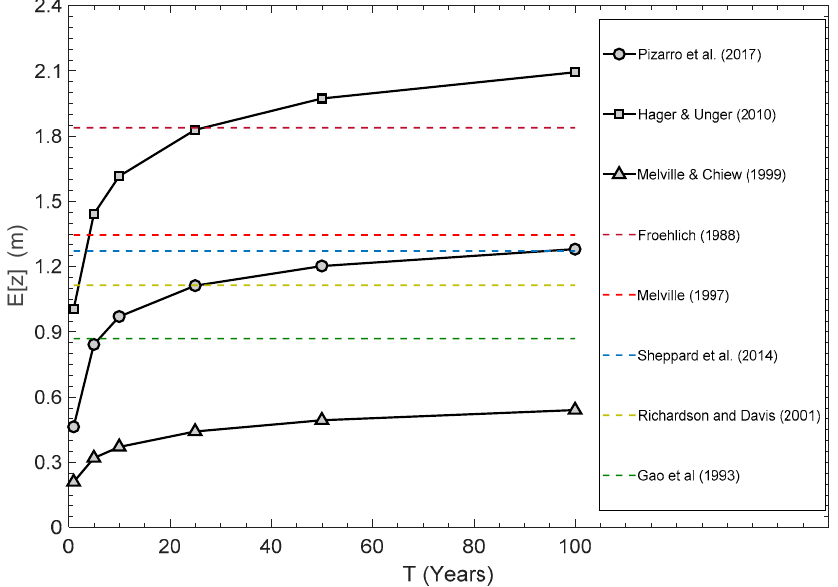
Figure 9. Comparison among expected scour values for three different time-dependent scour models and Equilibrium formulas. Q TR=100 = 5.6 m 3 /s.